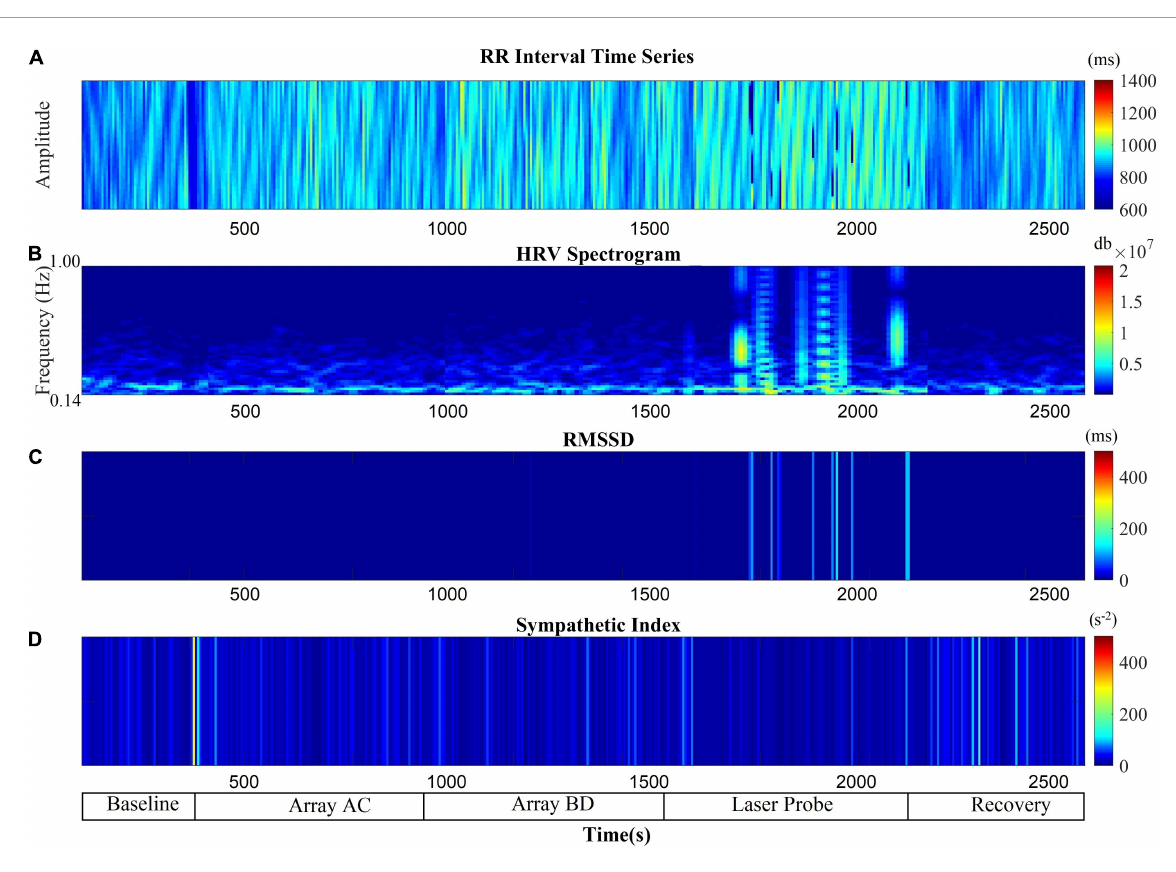
FIGURE4 Autonomic nervous system modulation as deduced from HRV changes during the entire protocol of one session of low-level laser therapy in one patient. (A) RR Intervals time series, (B) HF band power, (C) RMSSD, (D)